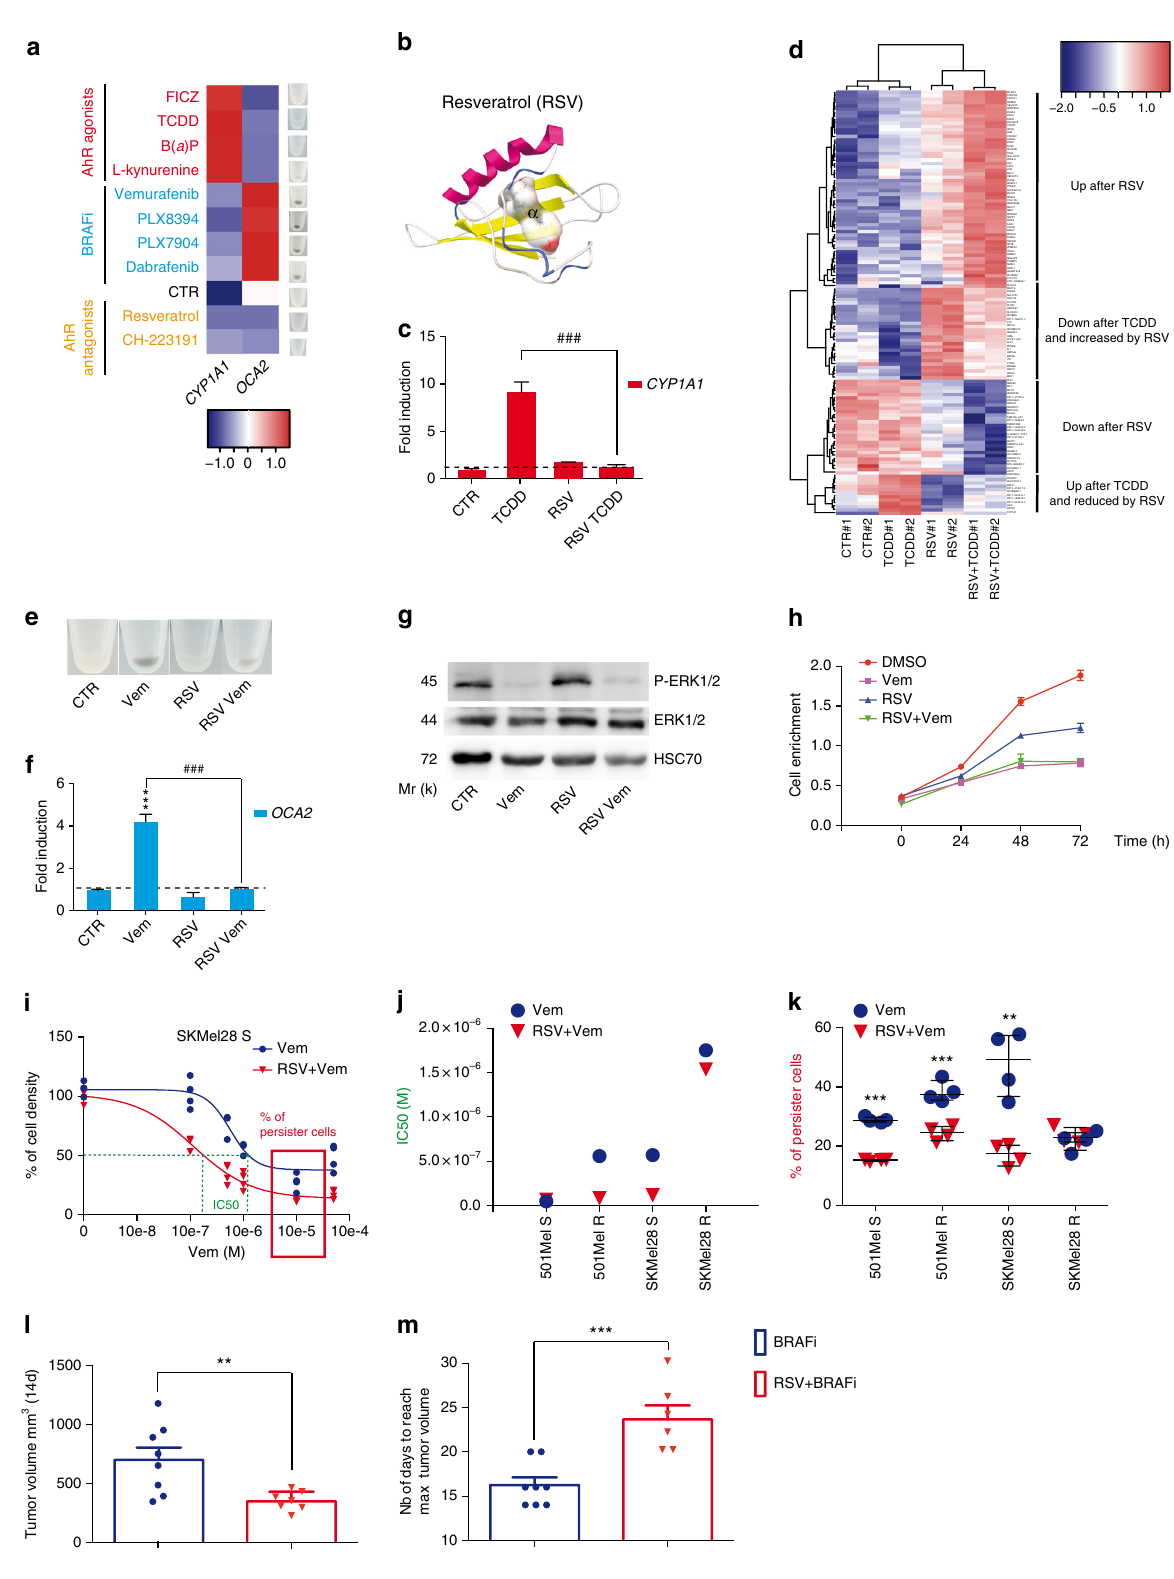
Pharmacologic treatment of mice . Mice with tumors reaching 200 – 300 mm 3 were treated via daily oral gavage. Dabrafenib (Biorbyt) and/or Resveratrol (Sell- eckchem) were dissolved in DMSO at a concentration of 30 and 40mg/ml respectively, aliquoted and stored at − 80 °C. Each day a new aliquot was diluted 1:10 with phosphate-buffered saline and mice were treated with a dose of 30 and 40 mg/kg for Dabrafenib and Resveratrol, respectively. Tumor volume